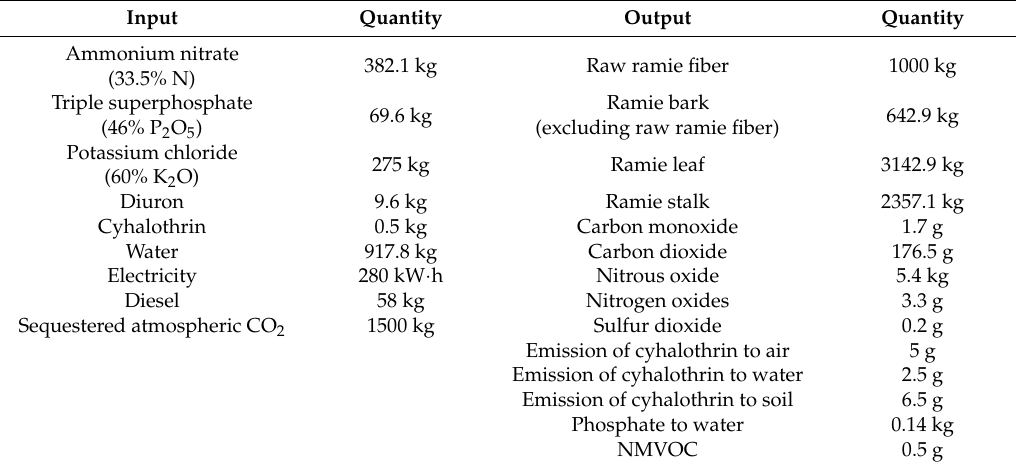
Table 2. Inputs and output of producing 1000 kg of raw ramie